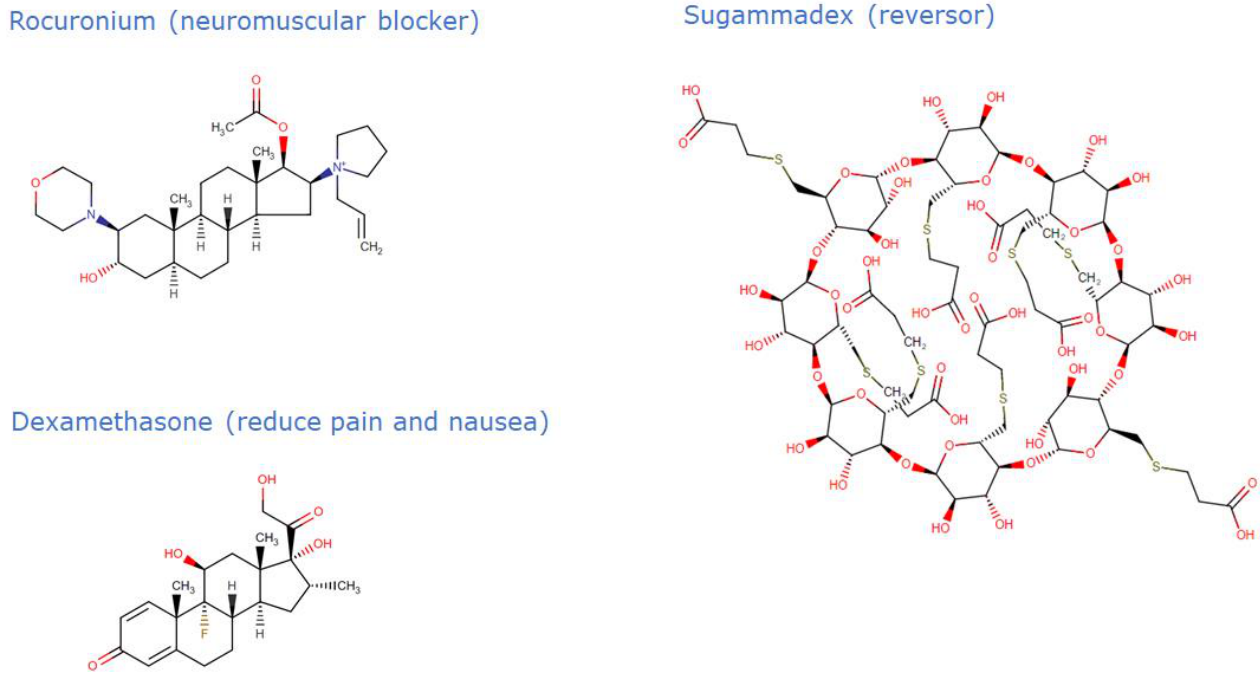
Figure 4. Chemical structure of the drugs rocuronium, sugammadex, and dexamethasone. Rocuronium is a non-depolarizing neuromuscular blocker (NMB) frequently used